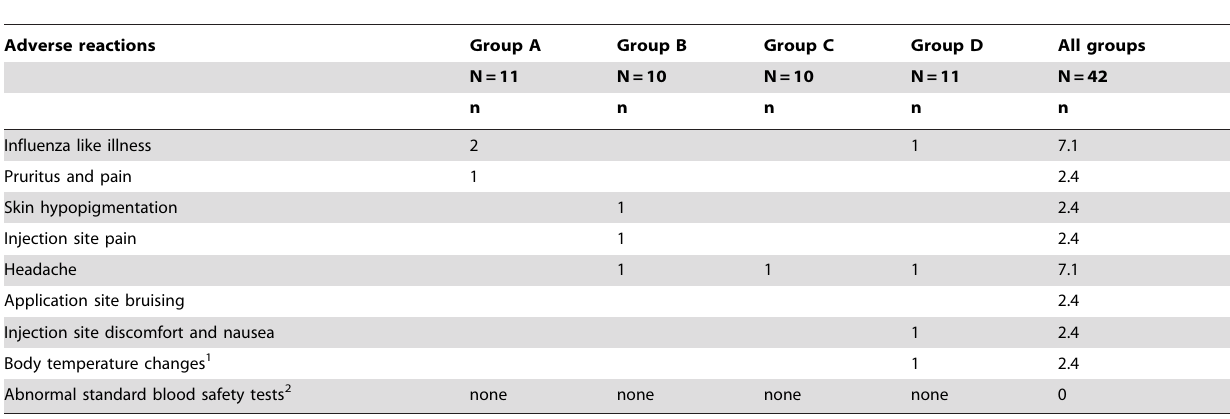
Abnormal standard blood safety tests